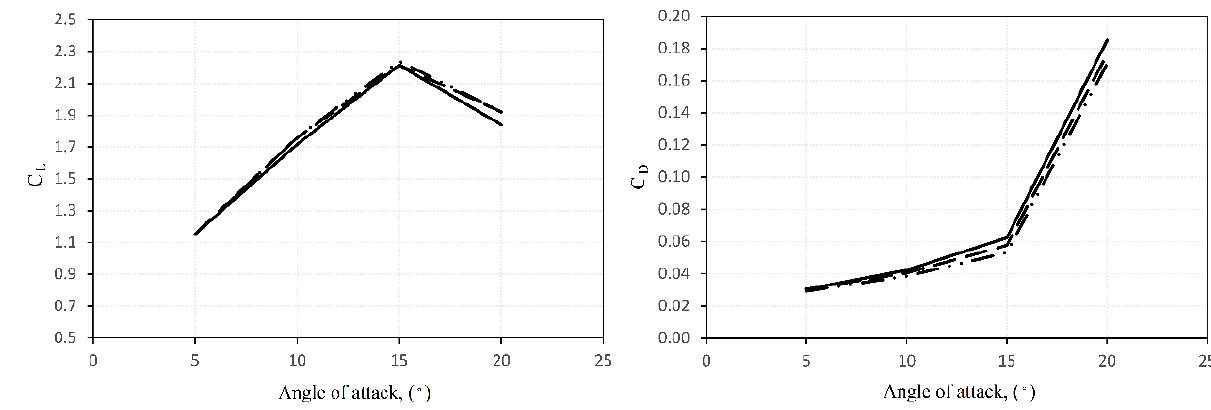
Figure 9. Lift and drag coefficients of the airfoil equipped with VGs in the presence of trailing-edge wedge with H / c =2% for the three grid levels. Grid level I ( solid ), Grid level II ( dashed ), Grid level III ( dashed dot dot